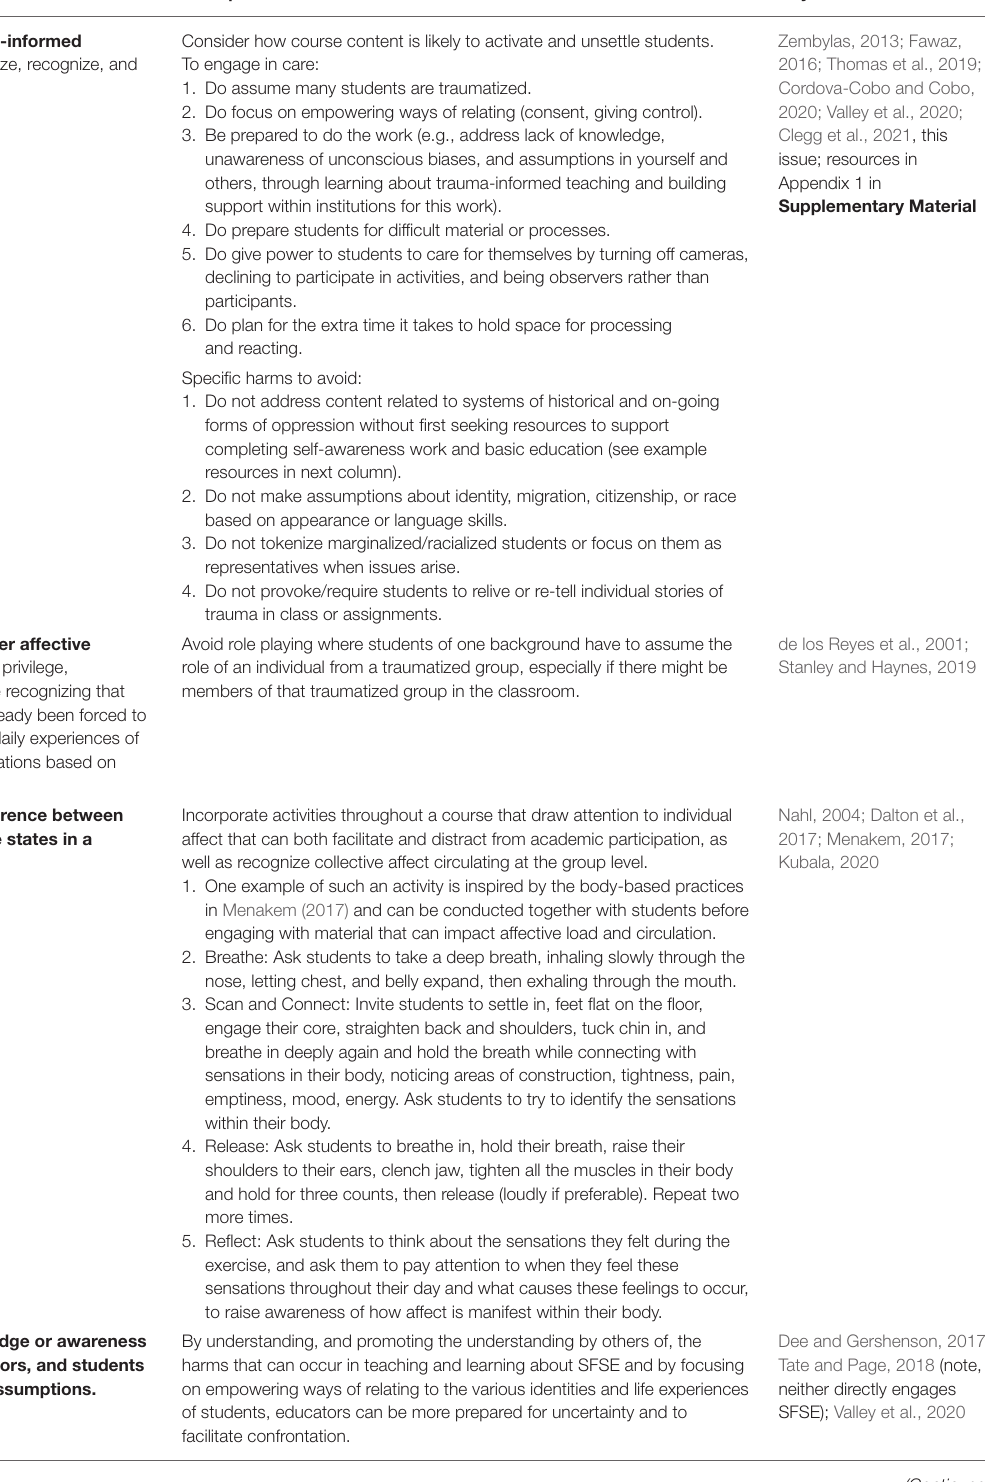
TABLE 1 | Strategies for educators to consider the role of emotion and affective state when centering equity in sustainable food systems education.